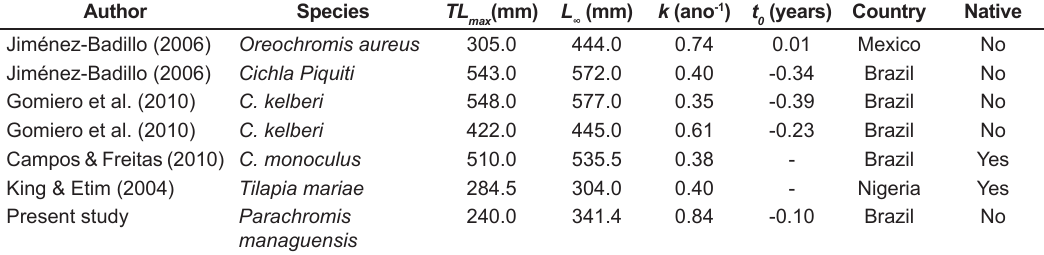
Table 2. Maximum length ( TL species estimated through length frequency